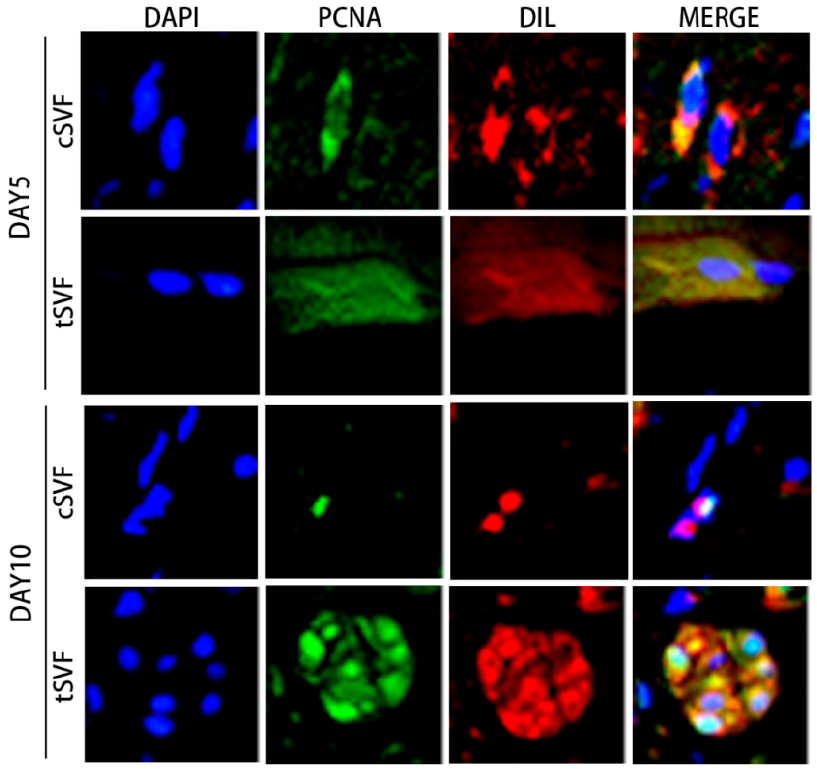
Figure 8. Cells co-expressed DIL and PCNA at day 5 and day 10 post injection in the cSVF and tSVF group. PCNA: proliferating cell nuclear antigen.